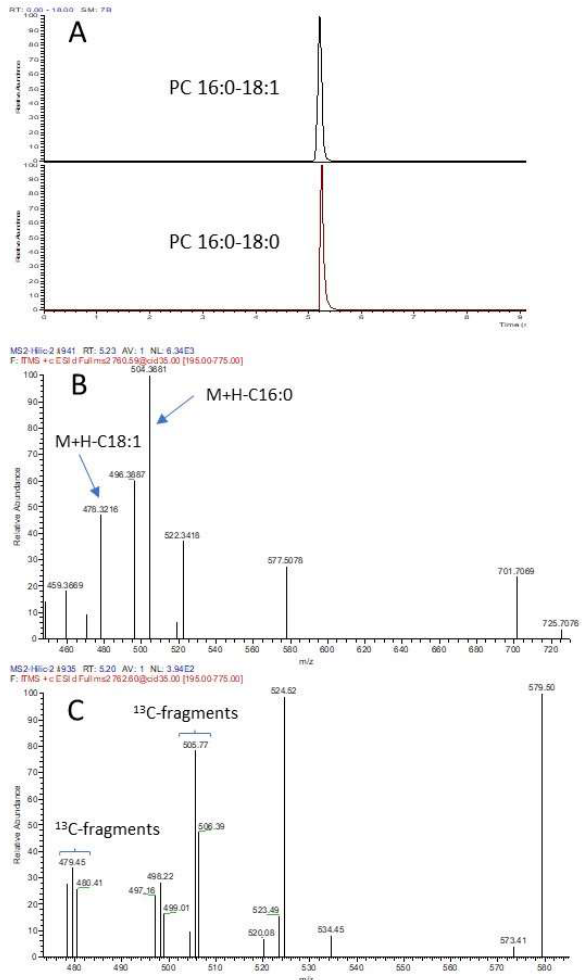
Figure 4. Hilic-MS profile of PC 34:1 and PC 34:0 parent ions and their respective MS2 spectra. Milk lipids were extracted using the Folch method and LC separation was by Hilic-4 method. ( A ): EIC of parent ions of PC 34:1 and PC 34:0; ( B ): MS2 spectrum of PC 34:1; ( C ): MS2 spectrum of PC 34:0.